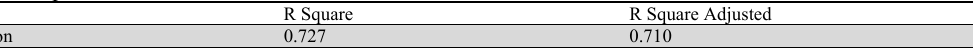
The results of R-Square